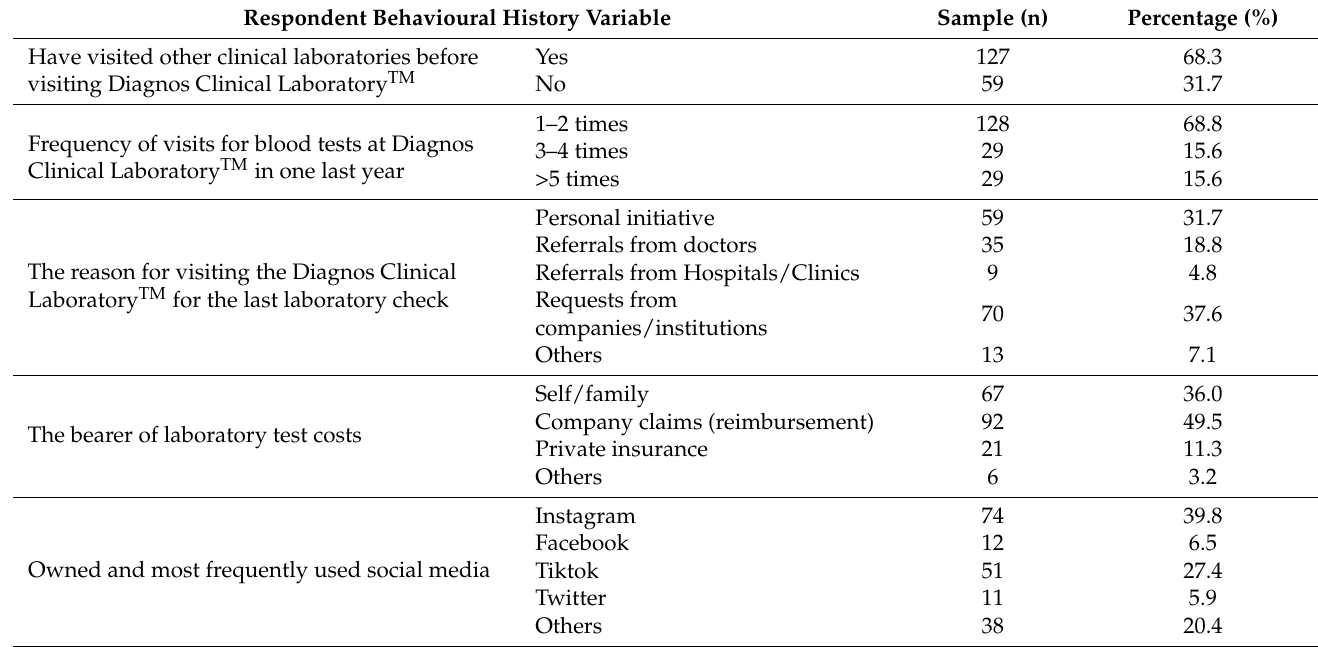
Table 3. Respondent behavioural history